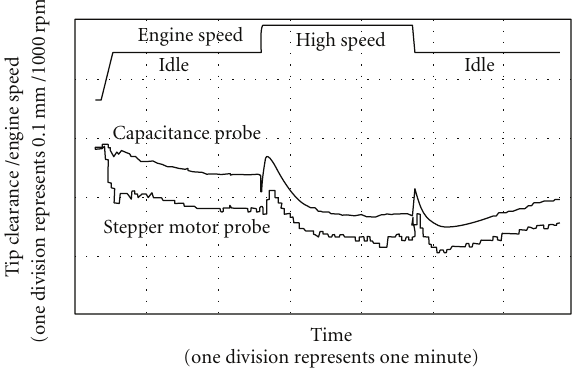
Figure 1: Trends in tip clearance. Measured by M¨uller et al. [3] using an electromechanical touch probe [4] and FM capacitance probe [2] in the high pressure turbine of a BMW Rolls-Royce GmbH BR700 development gas